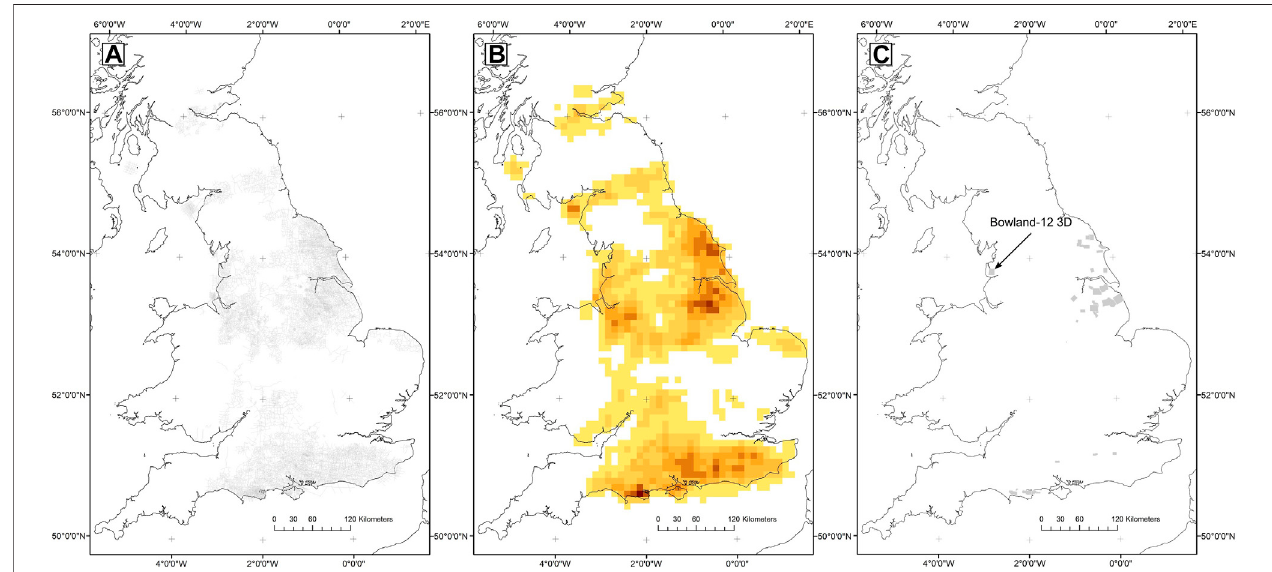
FIGURE 8 | A) 2D seismic data across the United Kingdom and (B) the number of line km of 2D seismic per 10 km 2 and (C) location of all 3D seismic re fl ection surveys onshore the United Kingdom (gray polygons) with the location of Bowland-12 3D survey highlighted.